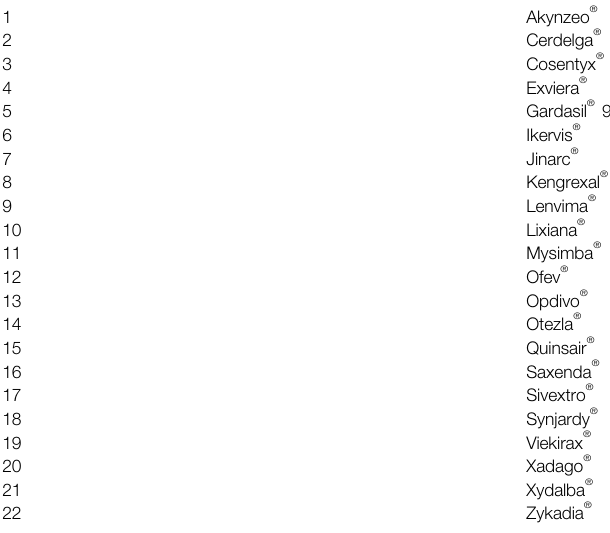
TABLE 1 | List of the compounds used in the Price Corridor